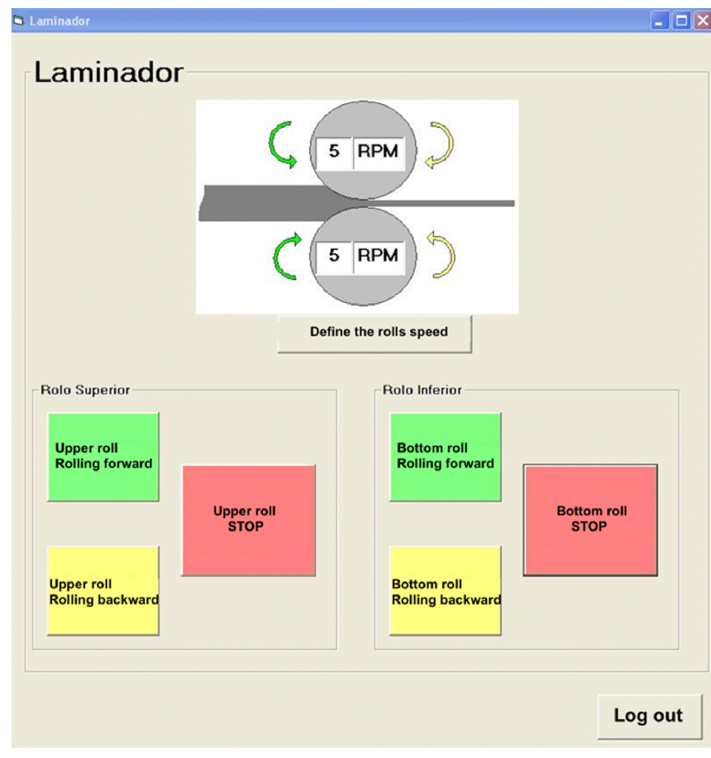
Figure 2. User interface for rolling mill